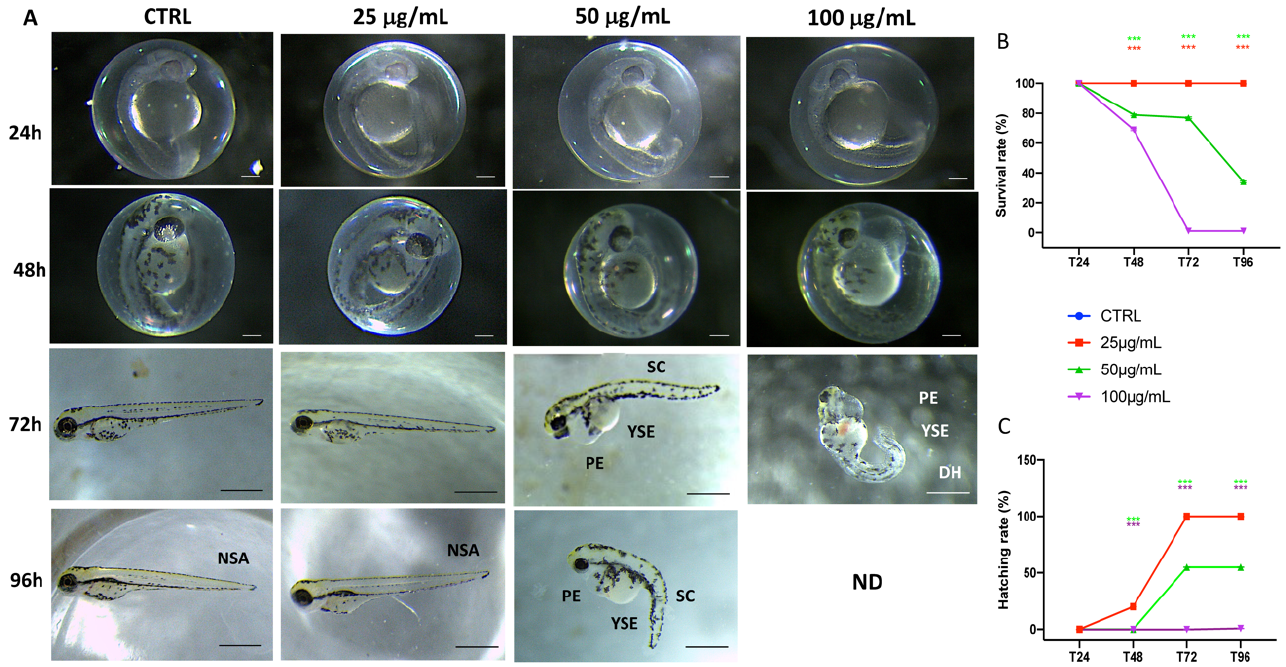
Figure 1. The morphological abnormalities in zebrafish caused by different fotemustine dose exposures ( A ), survival rate ( B ), and hatching rate ( C ). Images were taken from the lateral view under a dissecting microscope (magnification 25). Scale bar, 500 mm. PE—pericardial edema; YSE— Yolk sac edema; SC—scoliosis; DH—delayed hatching; NSA—normal spine axis. *** p < 0.001 versus CTRL.